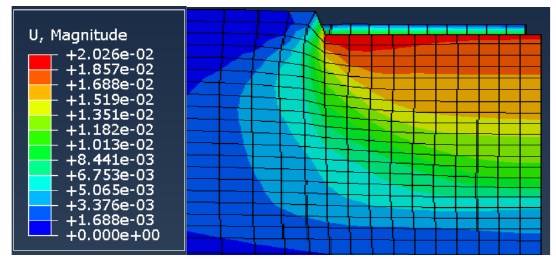
Figure 24 : Displacement contours of case 1 at h/B = 1.75 for L/B=2. Figure 25 : Displacement contours of case 8 at h/B = 1.75 for L/B=2